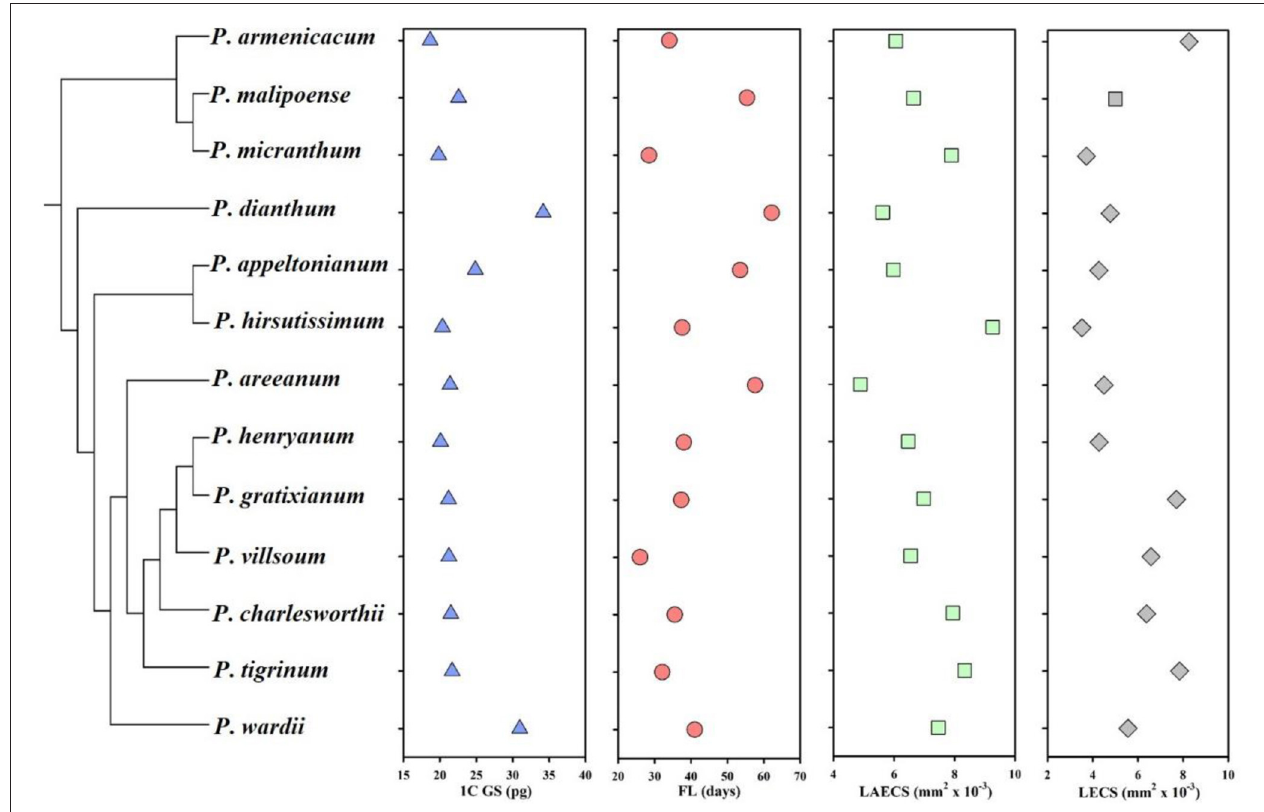
FIGURE 1 | Mean of raw values in genome size, floral longevity, and epidermal cell size of labellum and leaf from 13 Paphiopedilum species. GS, genome size; FL, floral longevity; LAECS, labellum epidermal cell size; LECS, leaf epidermal cell size. The phylogenetic relationships of the studied Paphiopedilum species in this study are obtained from the study by Cox et al. (1997) and Guo et al. (2015).